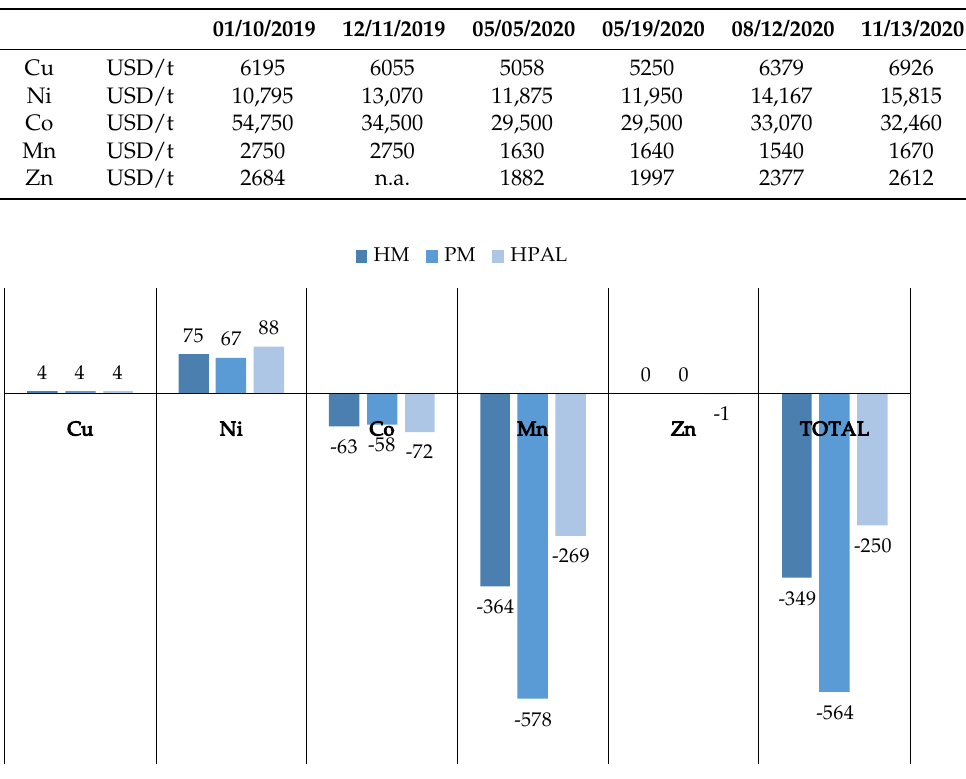
Figure 11. Aggregated revenue change based on HPAL technology (MUSD).